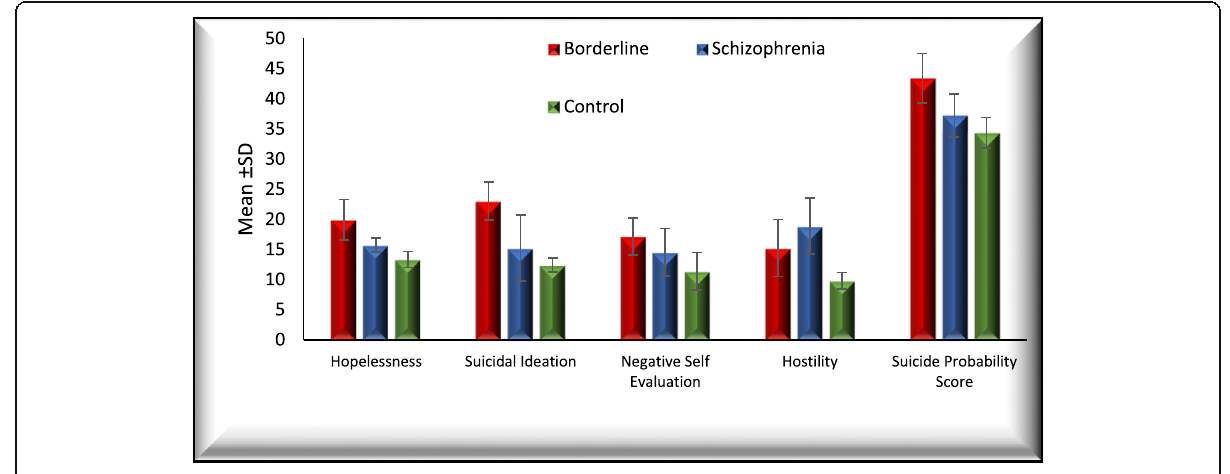
Fig. 2 Comparison of Suicide probability among the studied groups